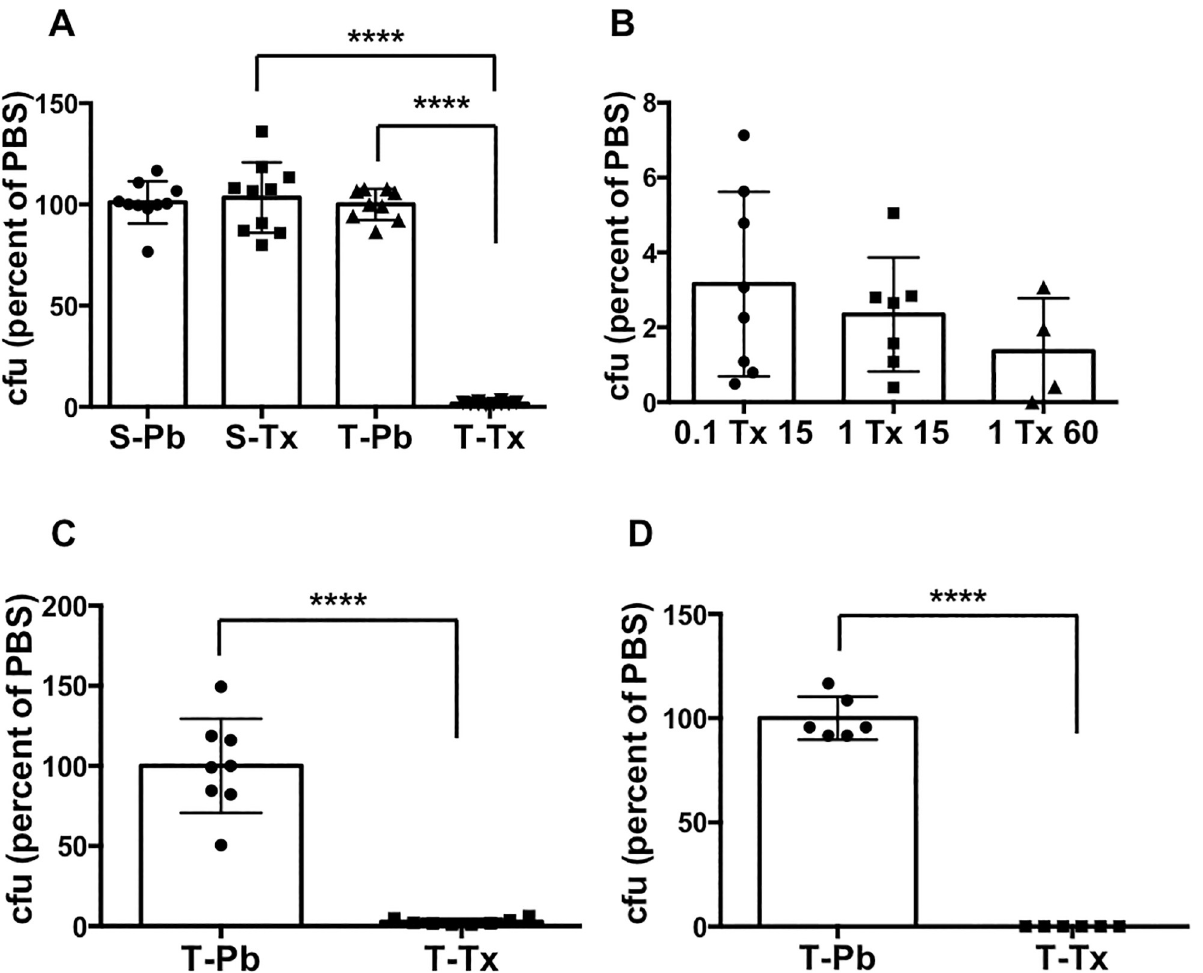
Fig 1. Effect of Triton X-100 in water on viability of SL1344 and Ty2. A. Equivalent numbers of SL1344 (S) or Ty2 (T) bacteria, grown overnight in static cultures, were incubated in PBS (Pb) or 1% Triton X-100 in water (Tx) for 1 hour on ice. The number of bacteria surviving in Triton was determined and expressed as a percentage of the number in PBS for each strain. ���� p < 0.0001, n = 9 or 10 per group. B. Equivalent numbers of Ty2 bacteria, grown overnight in static cultures, were incubated in PBS or in 0.1% or 1% Triton X-100 in water (Tx) for 15 or 60 minutes on ice as indicated. The number of bacteria surviving in Triton was determined and expressed as a percentage of the number in PBS (the values for PBS are not shown for ease of visualization). n = 4–8 per group. Note the different Y axis scales in A and B . C. Equivalent numbers of Ty2 (T), grown overnight in shaking culture, were incubated in PBS (Pb) or in 1% Triton X-100 in water (Tx) for 60 minutes on ice. The number of bacteria surviving in Triton was determined and expressed as a percentage of the number in PBS. ���� p < 0.0001, n = 8 per group. D. Equivalent numbers of Ty2 (T), grown overnight in shaking culture, were incubated in PBS (Pb) or in 1% Triton X-100 in water (Tx) for 60 minutes at 37˚C. The number of bacteria surviving in Triton was determined and expressed as a percentage of the number in PBS. ���� p < 0.0001, n = 6 per group.